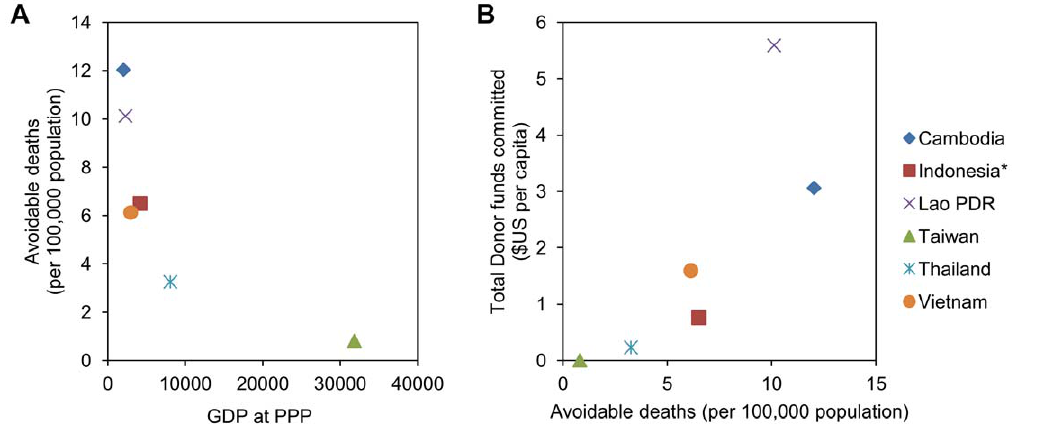
Figure 4. Association of predicted avoidable mortality rates with gross domestic product (A) and donor funding (B). Data on gross domestic product at product purchasing power (GDP at PPP) for 2009, obtained from the World Economic Outlook Database-April 2010,